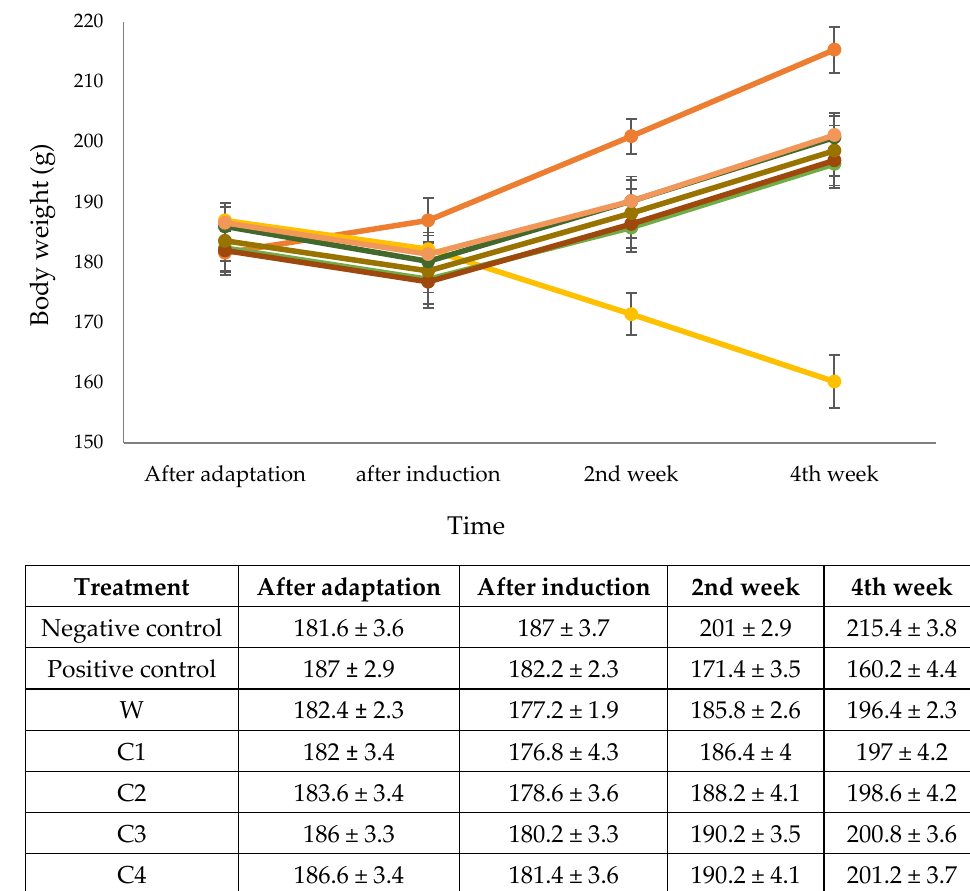
Figure 4. Weight body in diabetic Wistar rats pre and post of feeding. Note: negative control = non- diabetic rats; positive control = diabetic rats with normal diets; W = diabetic rats on wheat cookies diet; C1 = diabetic rats on C1 diet (corn cookies containing granulated sugar and margarine); C2 = diabetic rats on C2 diet (corn cookies containing crystalline coconut sugar and margarine); C3 = diabetic rats on C3 diet (corn cookies containing granulated sugar and VCO); C4 = diabetic rats on C4 diet (corn cookies containing crystalline coconut sugar and VCO). Different letters indicate a significant difference at the 5% level.